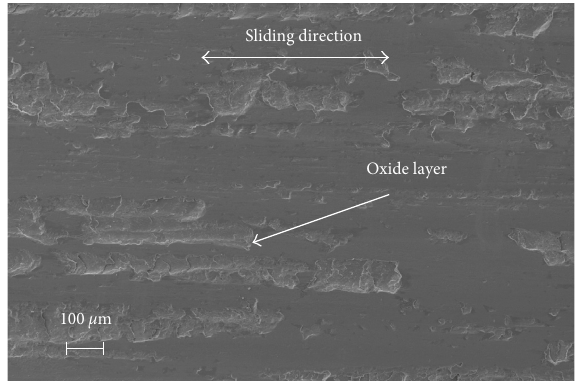
Figure 14: Scanning electron microscope micrograph of the steel 1 disk surface tested at 40 ° C.